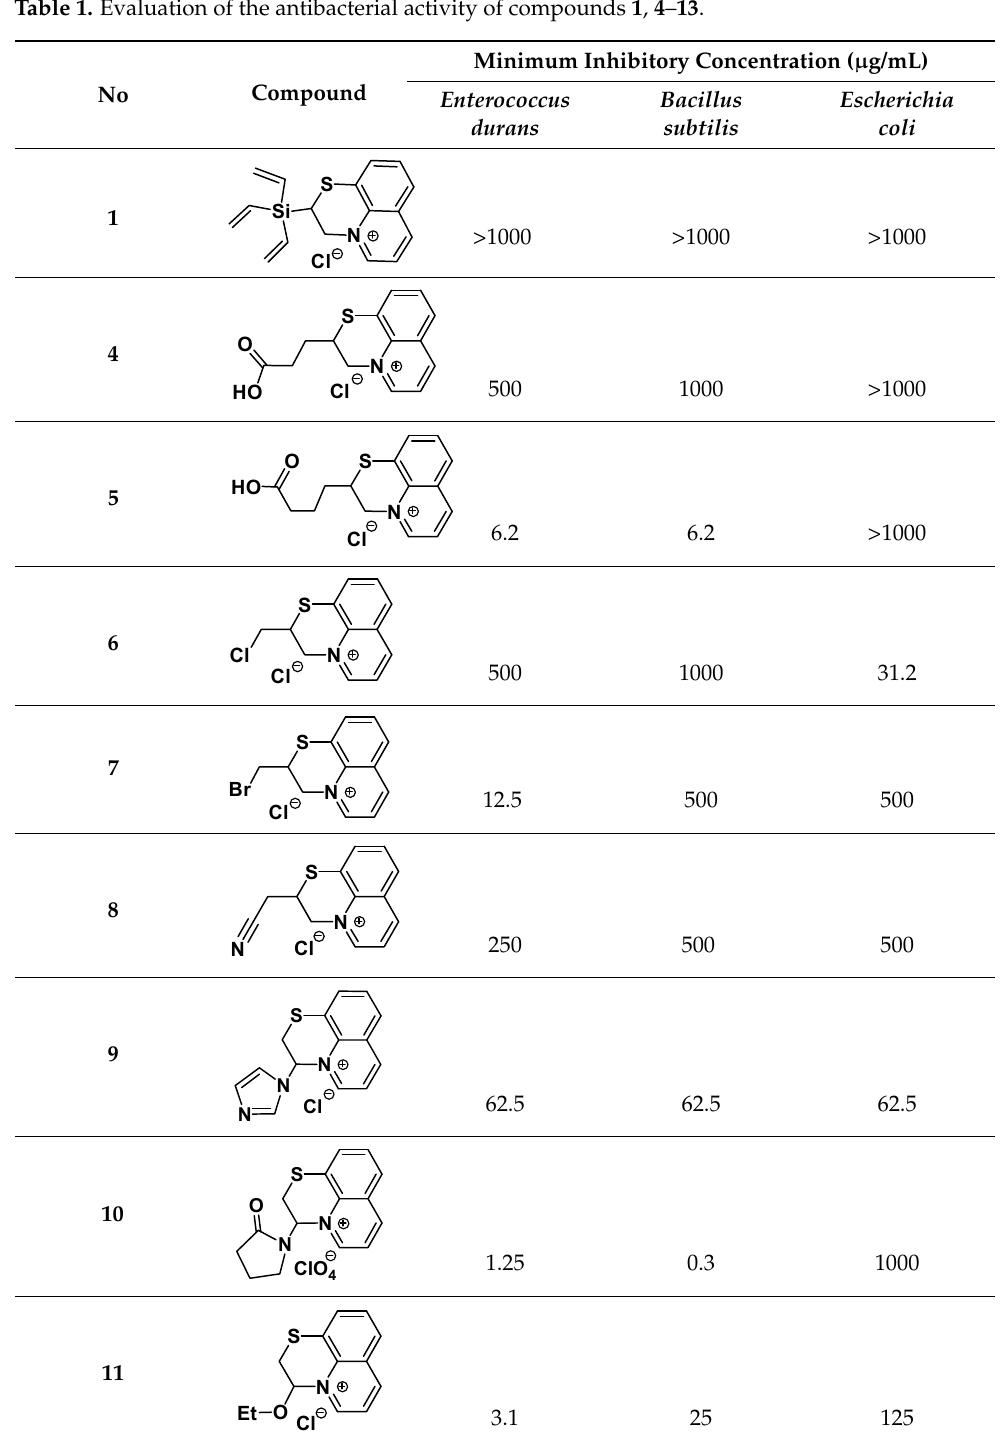
aminoglycoside antibiotic gentamicin (the minimal inhibitory concentrations are 25, 50 and 100 µ g/mL against E. durans , B. subtilis and E. coli , respectively). The obtained results are